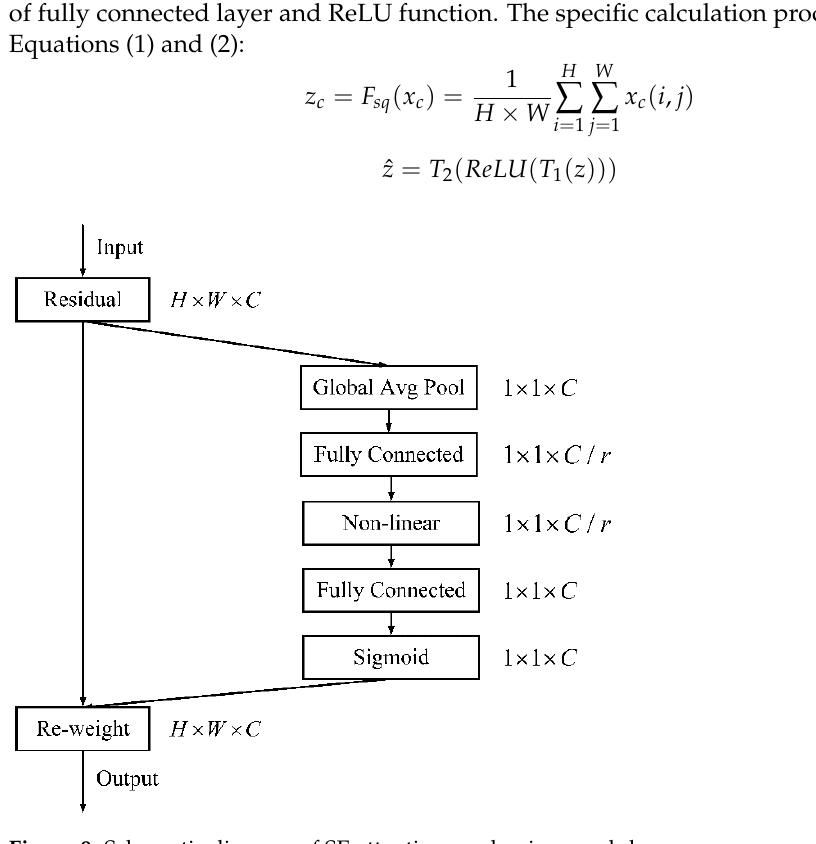
Figure 10. Schematic diagram of CA attention mechanism module. As can be seen from Figure 10, the CA attention mechanism module adds attention to the location information on top of considering the channel attention information. First, the global average pooling of the input image in both width and height directions is performed to realize the feature aggregation in both width and height directions and